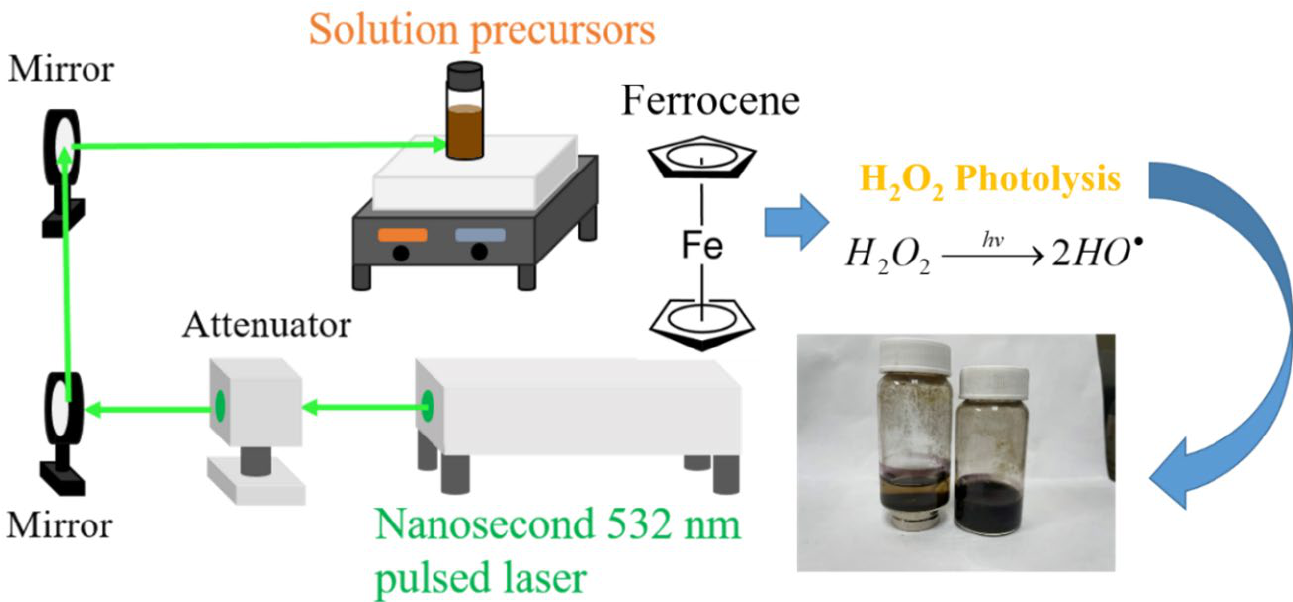
Figure 1. Schematic of experimental setup and precursors used for fabricating Fe 3 O 4 NPs through pulsed-laser-induced photolysis (PLIP). The photograph also shows the Fe 3 O 4 NPs separated from DI water under a magnet.